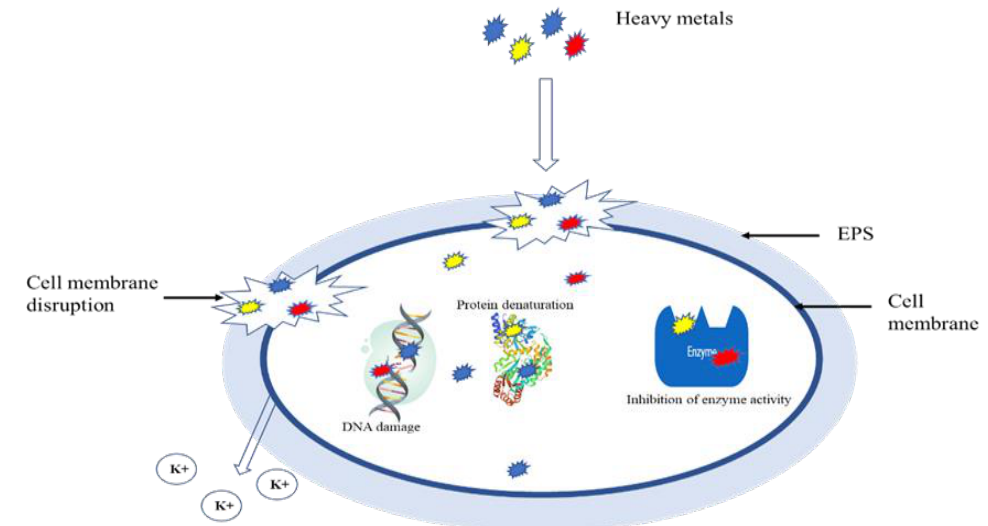
Figure 2. Inhibition of cell growth by toxic heavy metals. Edited from